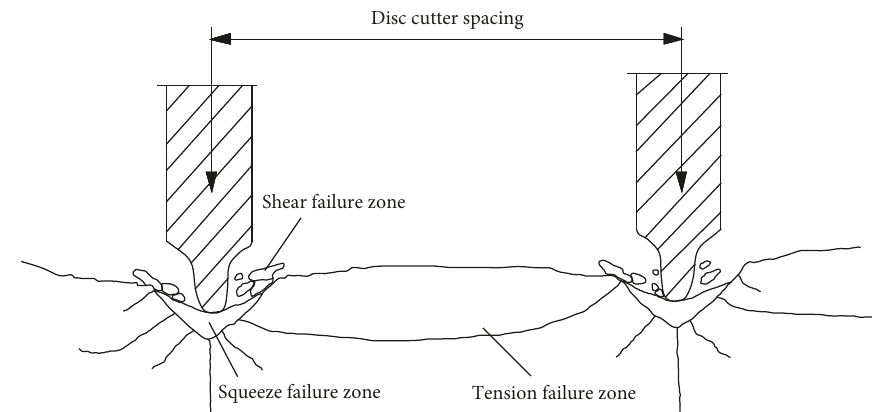
Figure 1: Rock-breaking mechanism of the disc cutter (Figure 1 is reproduced from Li et al. [29]).